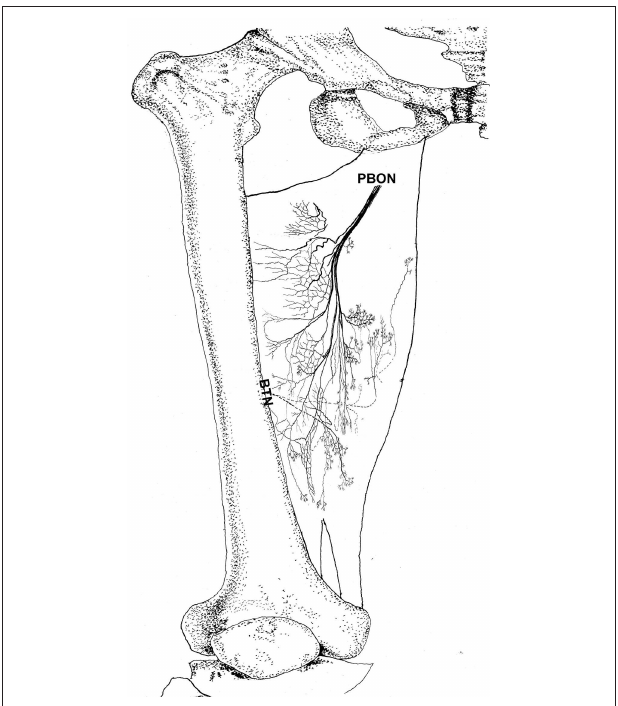
FIGURE 6 | Three dimensional pattern of intramuscular nerve distribution in the adductor magnus (right, superficial side; PBON, posterior branch of the obturator nerve; BTN, branch of the tibial nerve).